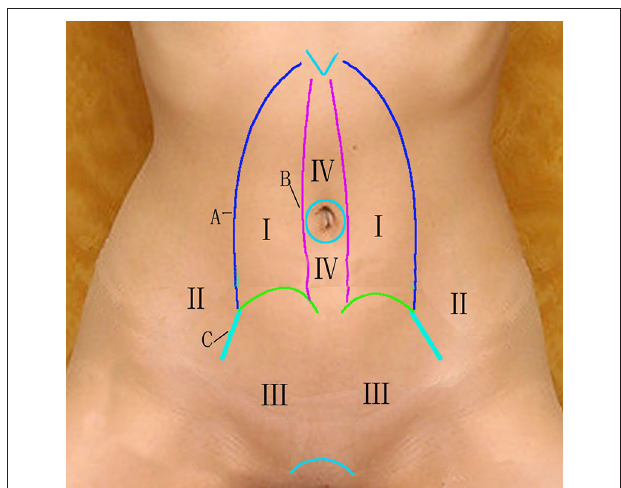
FIGURE 7 | Abdominal wall area. (I) between the rectus abdominis and posterior sheath of rectus abdominis; (II) the Bogros space; (III) Retzius space, and (IV) between the linea alba and peritoneum. (A) between the lateral edge of the posterior sheath of the rectus abdominis and transverse abdominal muscle; (B) between the medial border of the posterior sheath of the rectus abdominis; and (C) between the transverse fascia of the abdomen extending downward and thickening at the outer edge of the arcuate